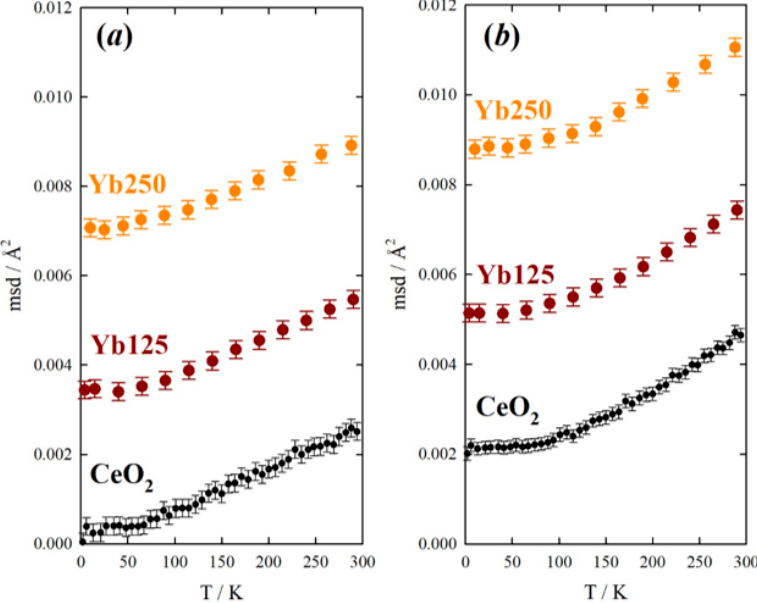
Figure 3. Msds computed from Rietveld refinements of temperature resolved NPD patterns for ( a ) cation and ( b ) oxygen sites.